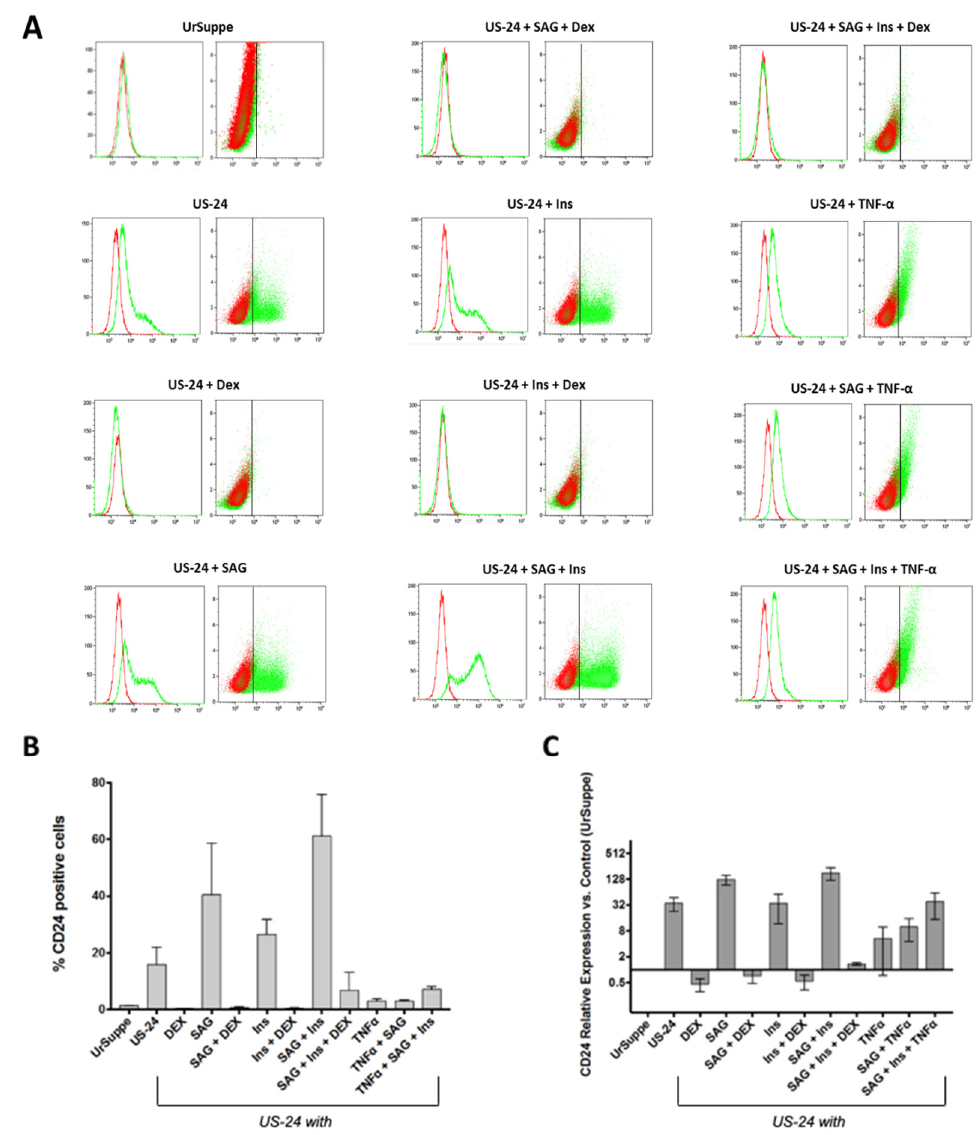
Figure 1. Analysis of CD24 expression in hASCs. The cells were expanded in UrSuppe up to passage P2. Once the confluence was reached, the usual cell culture medium was replaced by US-24 . Additionally, the following factors were added, as indicated: Ins (Insulin), Dex (Dexamethasone), SAG, and TNF α . ( A ) Cells were analyzed by flow cytometry: Representative histograms and plots depicting the CD24 expression in response to different treatments. Red line and spot: the isotype control; Green line and spot: Specific anti-CD24 antibody. ( B ) Quantification of the flow cytometry analysis of CD24 expression. Percentage of CD24 positive cells depending on the cell culture conditions indicated on the histogram’s x -axis ( n = 3, error bars represents S.E.M., complete statistical significance reported in Supplementary Materials Table S1). ( C ) Quantification of CD24 expression by RT-qPCR in response to the different treatments indicated on the x -axis. The histogram shows the relative fold-expression change related to the CD24 expression value measured in hASCs grown in UrSuppe ( n = 3, error bars represent Standard Error of the Mean (S.E.M.), complete statistical significance reported in Supplementary Materials Table S2).